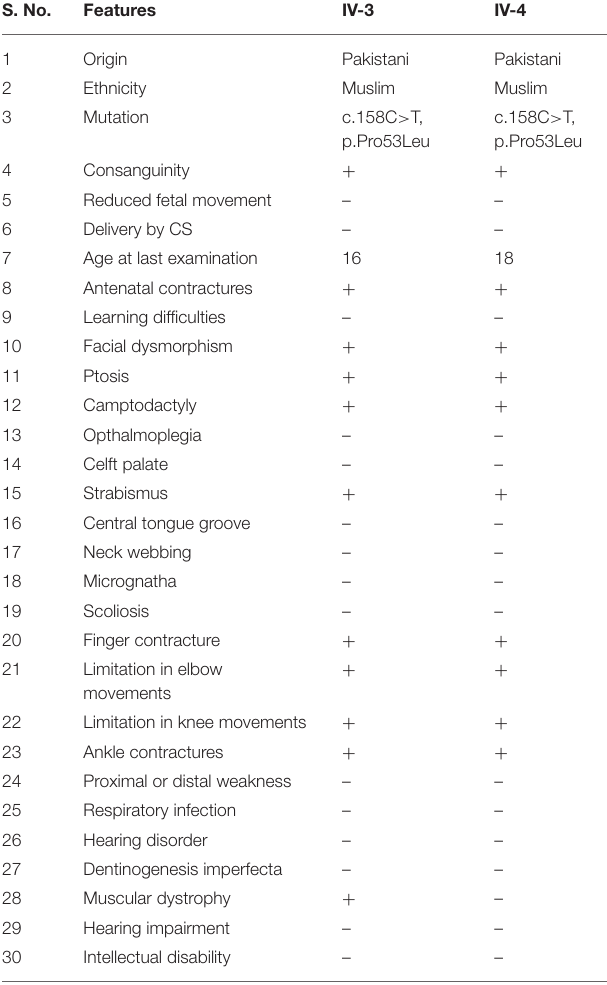
TABLE 1 | Clinical examination of the two affected individuals. S. No.